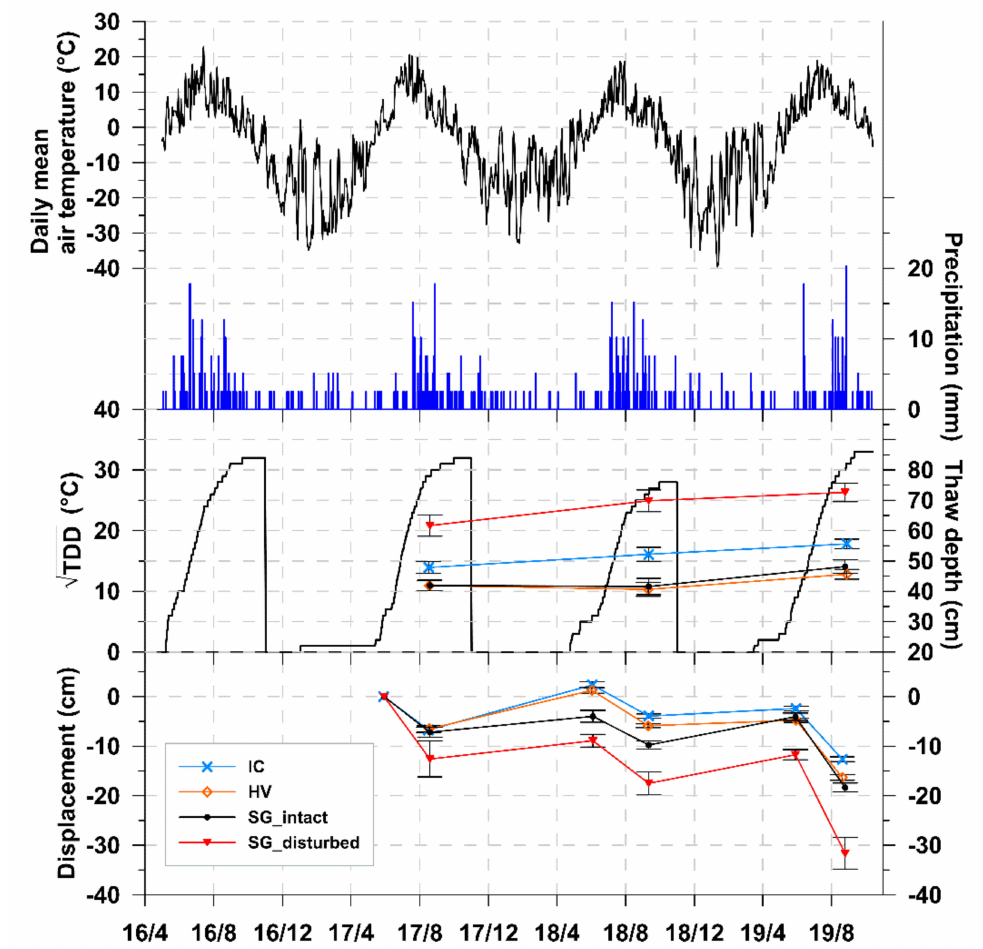
Figure 3. Temporal changes in weather conditions, thaw depth, ground-surface displacement, and thawing degree days (TDD). The error bars for thaw depth and displacement indicate two standard errors (95.45% confidence interval). Table 1. Meteorological statistics for 2017–2019. The summer period was defined as June–September. TDD and FDD are thawing and freezing degree days, respectively; of